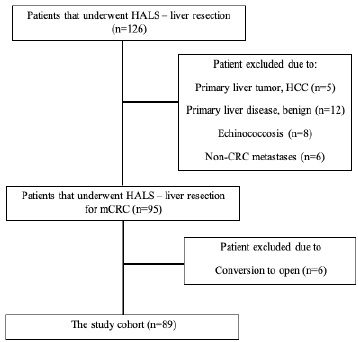
Figure 2. Prisma flowchart of the study. Table 1. Patient demographic and clinical